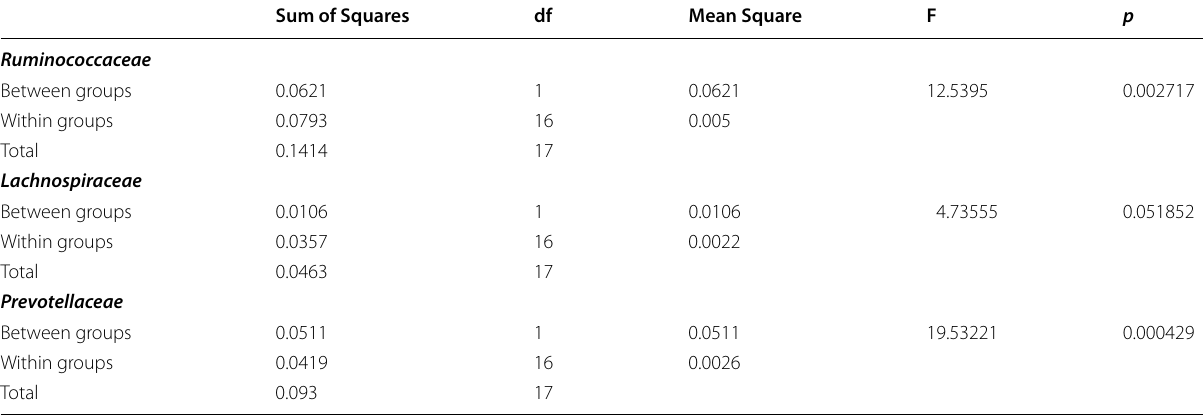
Table 1 Analysis of Variance (ANOVA) and Tukey test between juvenile (FPJ) and adult feral pigs (FPA) Sum of Squares df Mean Square F